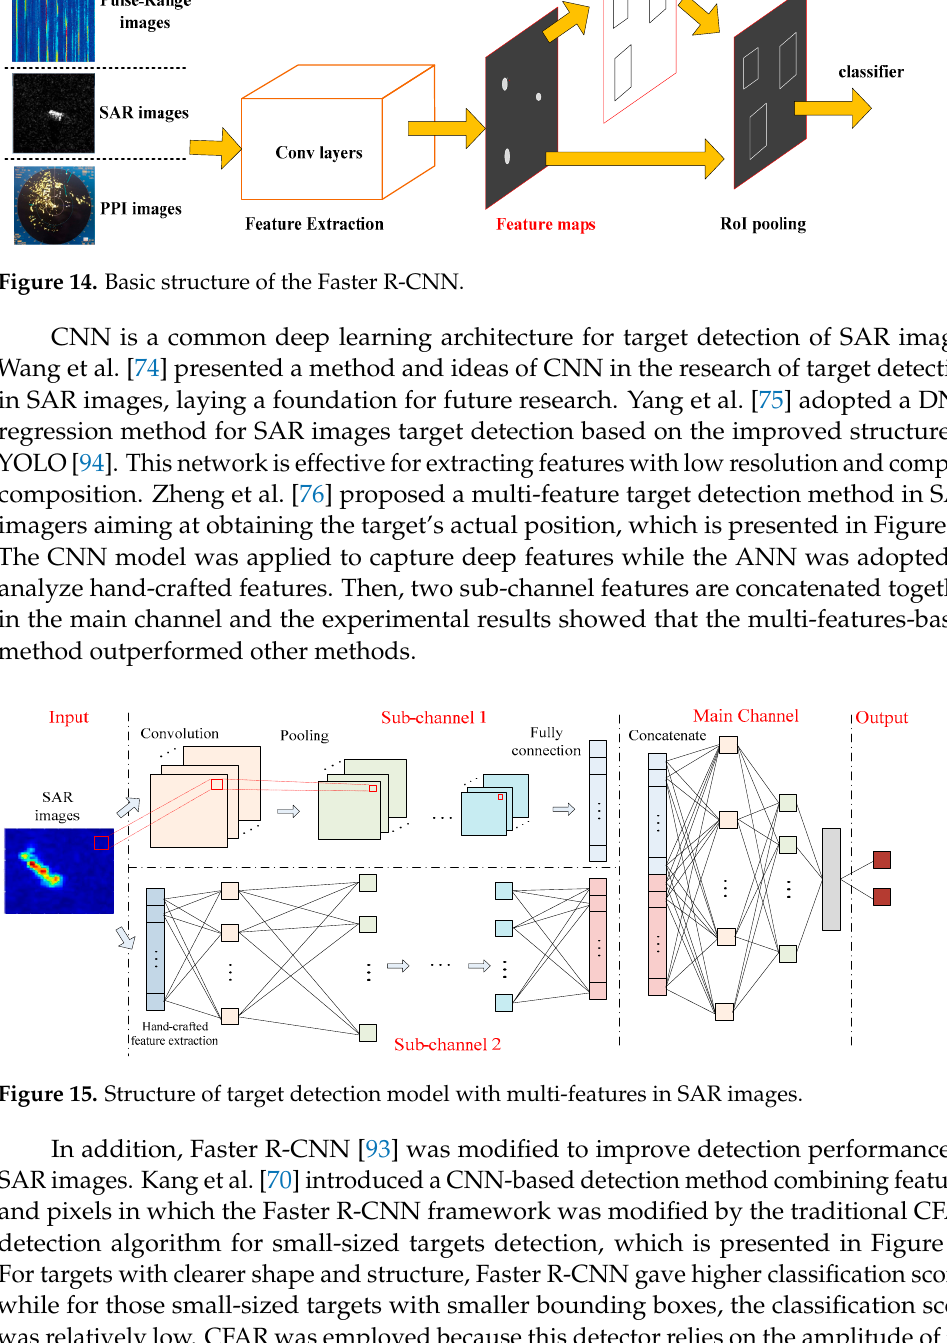
15 of 30 Figure 13. Faster R ‐ CNN ‐ based model for RTD with Pulse ‐ Range images. We can find that classic object detection methods based on CNNs, especially Faster R ‐ CNN and SSD, which have been widely employed to RTD. Girshick et al. [92] trans ‐ formed the detection task into a classification task and proposed Fast R ‐ CNN structure. Ren et al. [93] depicted a new region proposal network (RPN) to implement the end ‐ to ‐ end target detection based on Faster R ‐ CNN and RPN with shared convolutional features